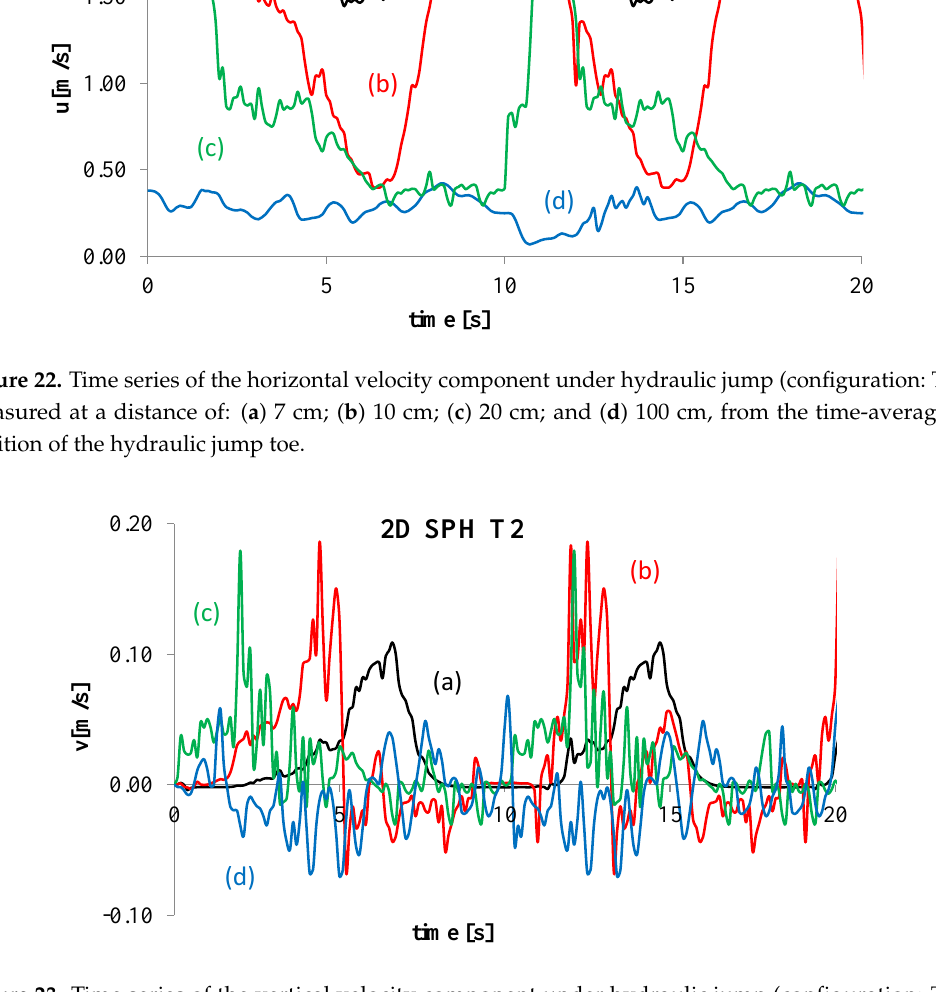
Figure 23. Time series of the vertical velocity component under hydraulic jump (configuration: T2) measured at a distance of: ( a ) 7 cm; ( b ) 10 cm; ( c ) 20 cm; and ( d ) 100 cm, from the time-averaged position of the hydraulic jump toe.